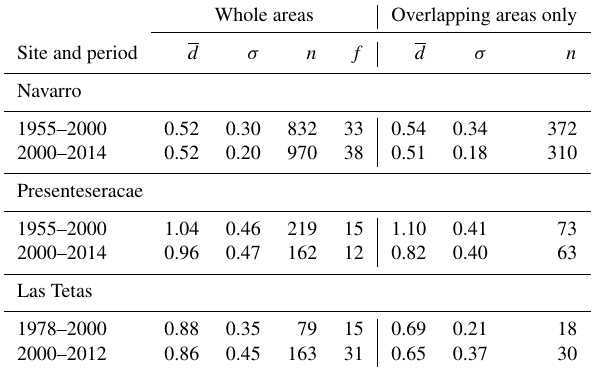
Table 4. Summary statistics of horizontal displacements detected on the landform surfaces (see text for further details). The mean displacement ( d , myr − 1 ) and standard deviation ( σ , myr − 1 ) are presented for the entire (snow-free) areas where movement was de- tected, and then only for the overlapping areas where movement was detected during both periods compared. The latter aimed at re- moving the spatial sampling bias when comparing movement statis- tics over time. n refers to the numbers of vectors retained and f to the corresponding fraction (%) of snow-free areas where movement was